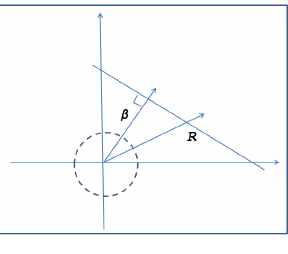
Figure 2. Geometric interpretation of simple reliability